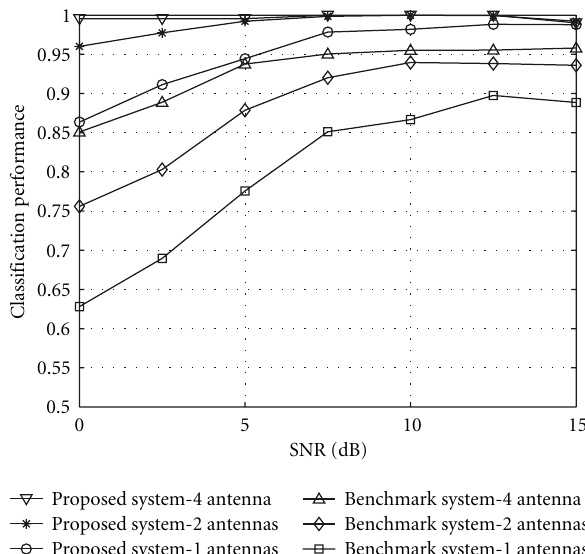
Figure 13: Classification performance of proposed initial SOF- based classification stage and benchmark in a slow 20-path fading channel using the MRC-variant combining